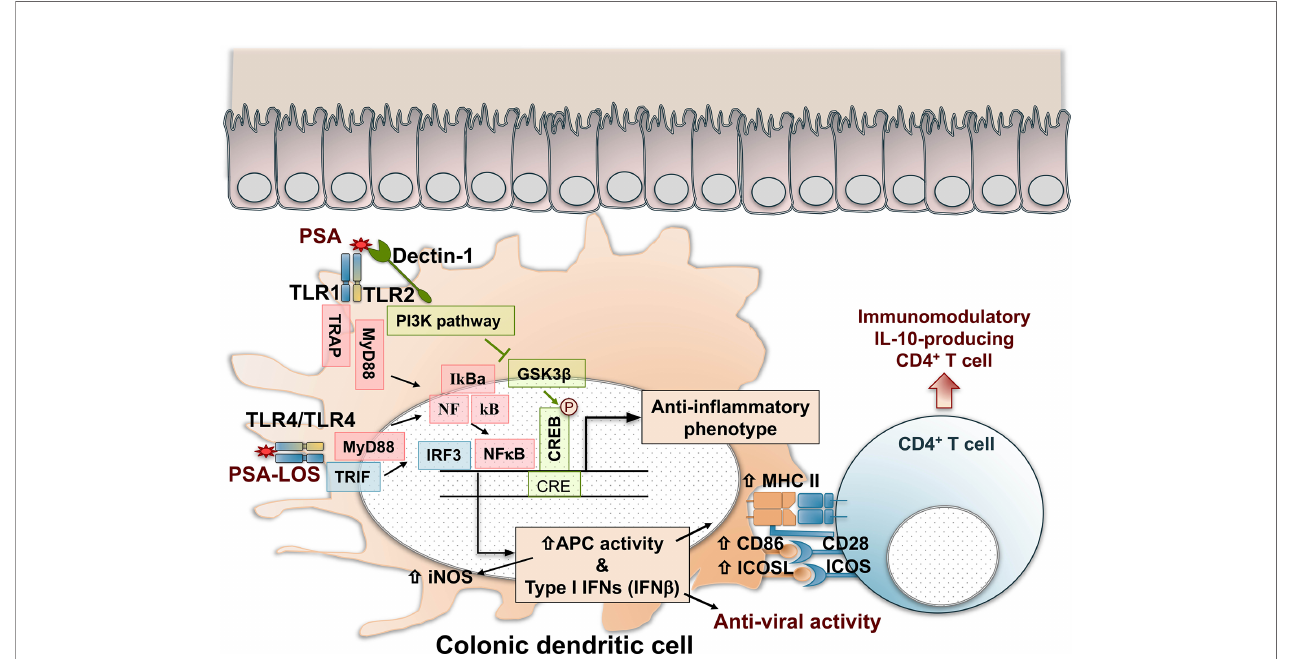
FIGURE 1 | Recognition, cell signaling, and immunomodulatory pathways triggered by PSA in colonic dendritic cells. PSA is recognized by TLR1/TLR2 dimers that result in NF-kB nuclear translocation and IRF-mediated activation of Type I IFN gene expression and enhanced antigen processing and presentation by increased expression of iNOS, MHC class II molecules, and costimulatory signals mediated by CD86 and ICOSL. In addition, Dectin-1, a C-Type Lectin pattern recognition receptor, contributes with TLR2 in the cell signal activation through the PI3K pathway, resulting in the nuclear phosphorylation and activation of CREB, triggering the expression of anti-in fl ammatory genes. As a result, naïve CD4 + T cells are activated and differentiated in IL-10-producing immunomodulatory cells with Foxp3, CD39, Tr1 phenotypes that might depend on the in fl ammatory condition (IBD, asthma, EAE, or other). PSA recognition by TLR4 dimers induces the production of IFN- b with anti-viral activity through a MyD88 and TRIF-dependent pathway. The activation of TLR4/TRIF is dependent on the lipooligosaccharide (LOS) portion of the polysaccharide. CREB, cAMP response element – binding protein; GSK3 b , glycogen synthase kinase 3 b ; IFN, interferon; IL-10, interleukin 10; iNOS, inducible nitric oxide synthase; IRF, interferon regulatory factors; MHC II, major histocompatibility complex class II; MyD88, myeloid differentiation primary response 88; NFkB, nuclear factor-kB; PSA, polysaccharide A; PI3K, phosphoinositide 3-kinase; TLR, toll-like receptor; TRAP, tumor necrosis factor receptor-associated protein. TRIF, TIR domain-containing adapter-inducing